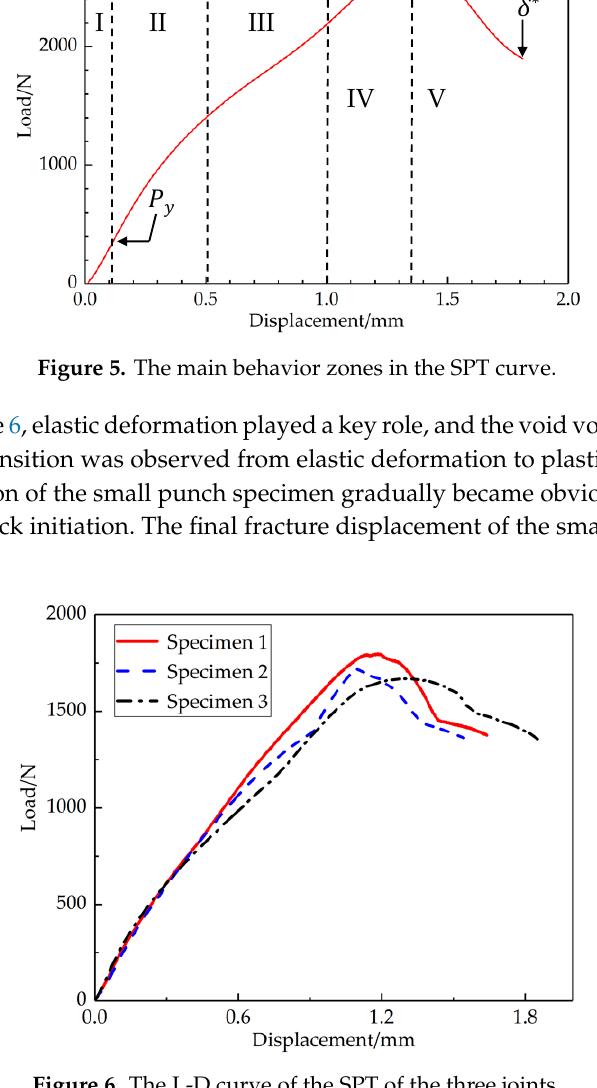
Table 5. The J IC data from our calculations.